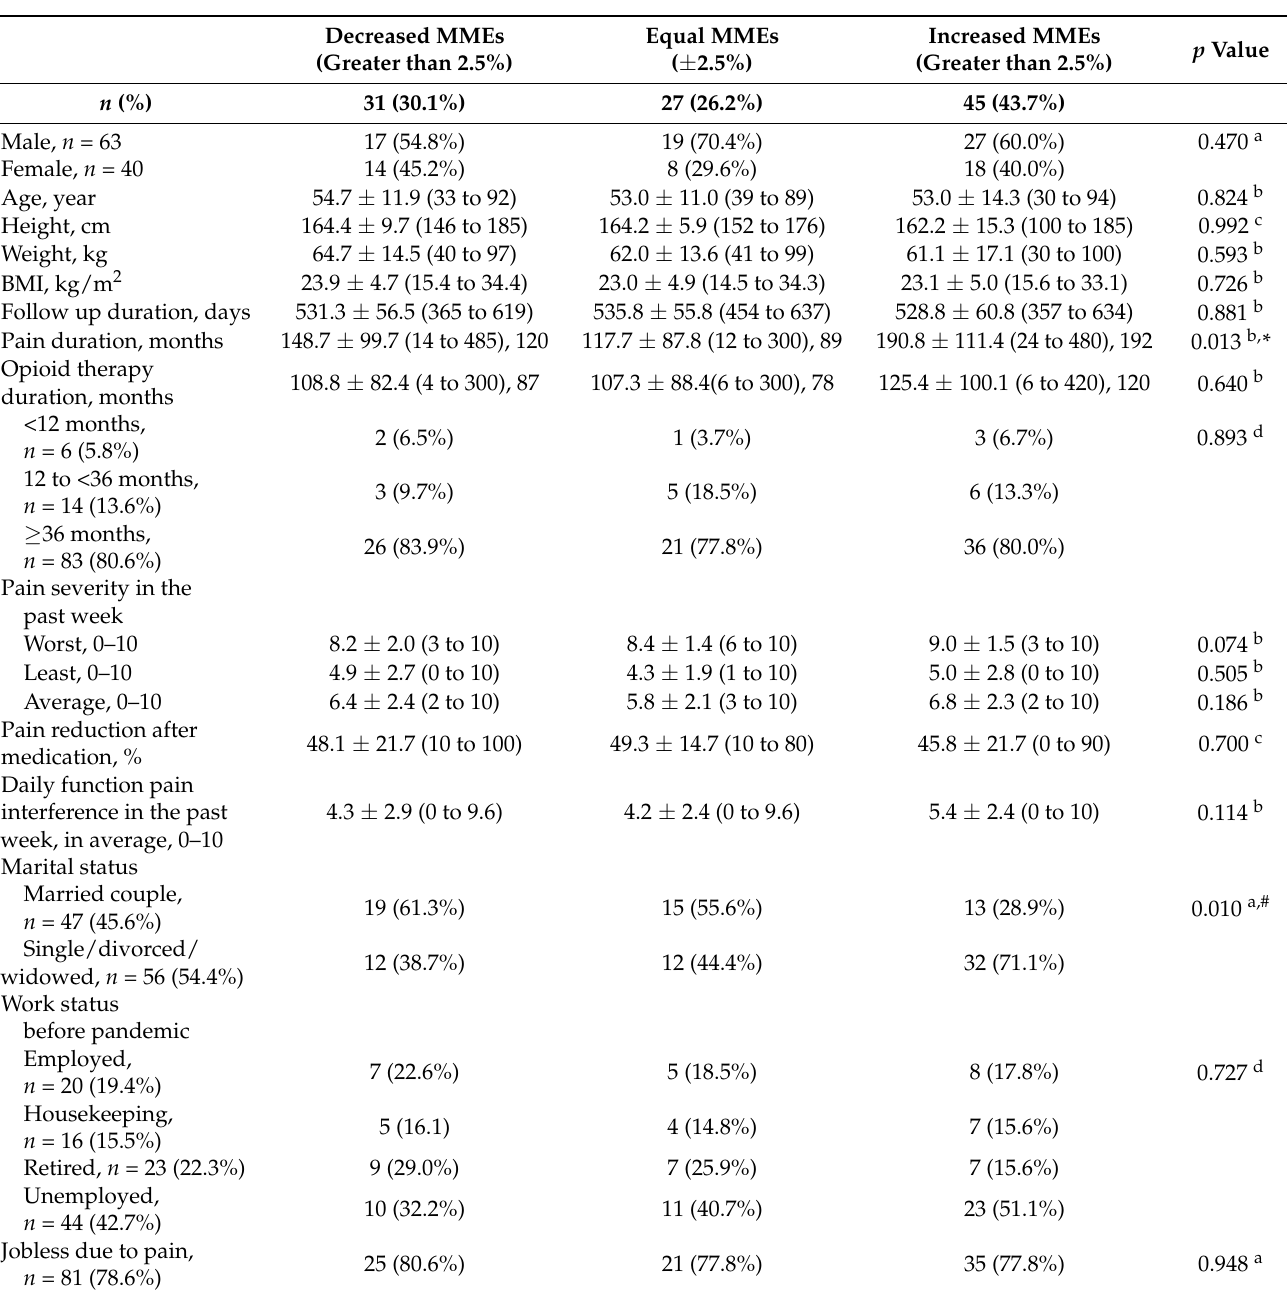
Table 1. Patient data ( n =